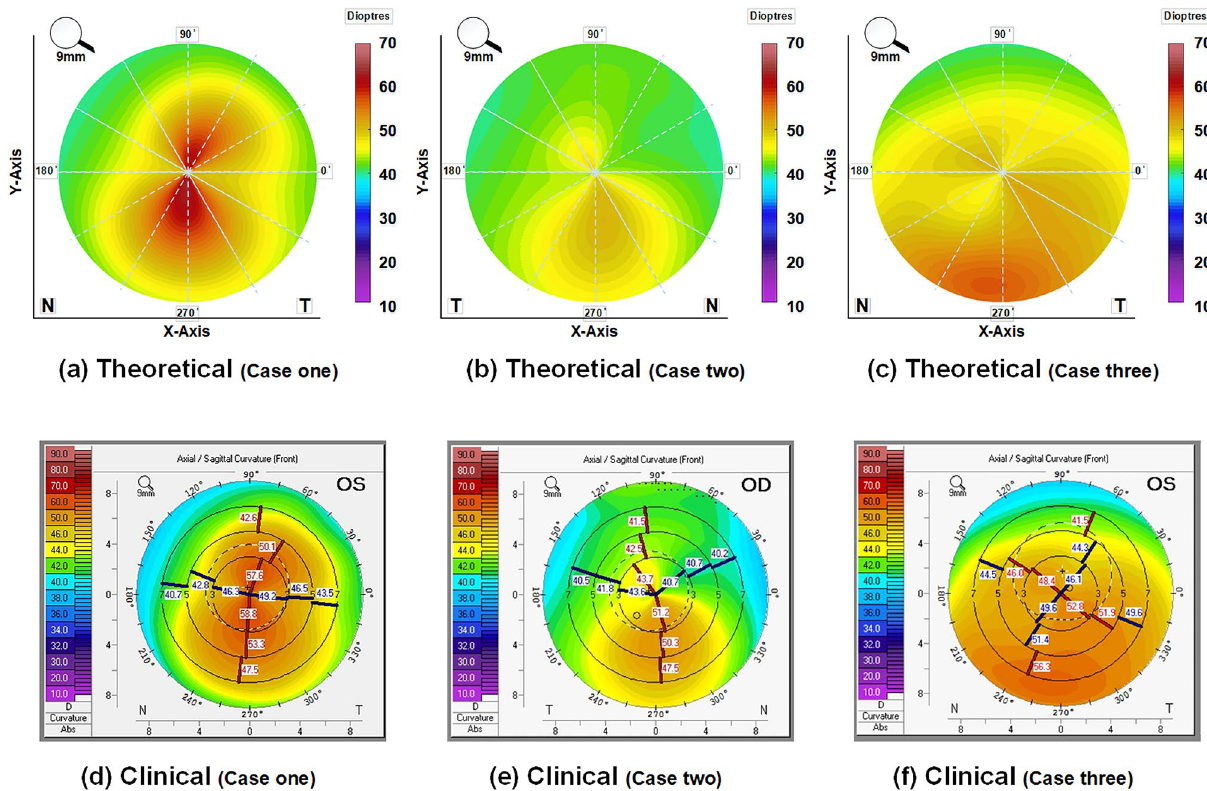
Figure 8. The preoperative axial maps: theoretically obtained from Pentacam elevation data for three individual case scenarios (the first row); the clinically reported axial maps for each case (the second